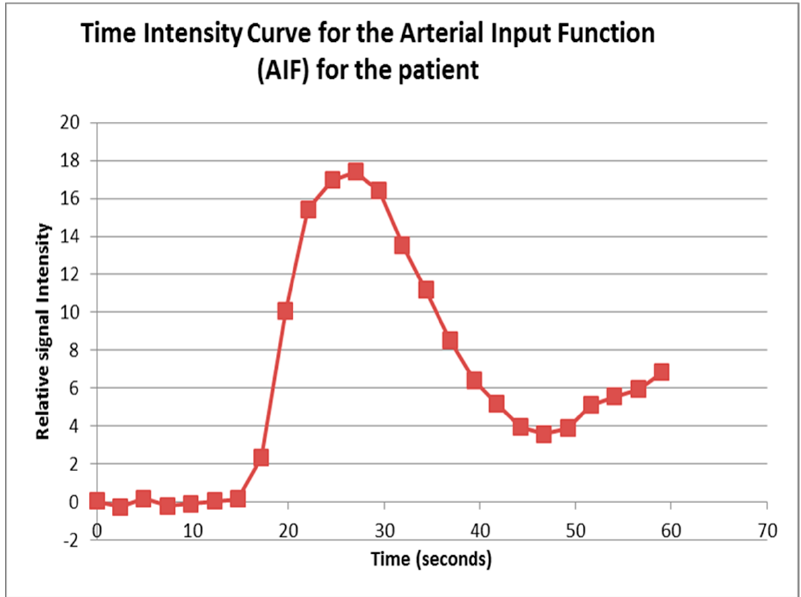
Figure 2. The time intensity curve produced by the Platform for Research in Medical Imaging (PMI) version 0.4 Software for arterial input function (AIF) as outlined by region of interest (ROI) in the aorta as in Figure 1.